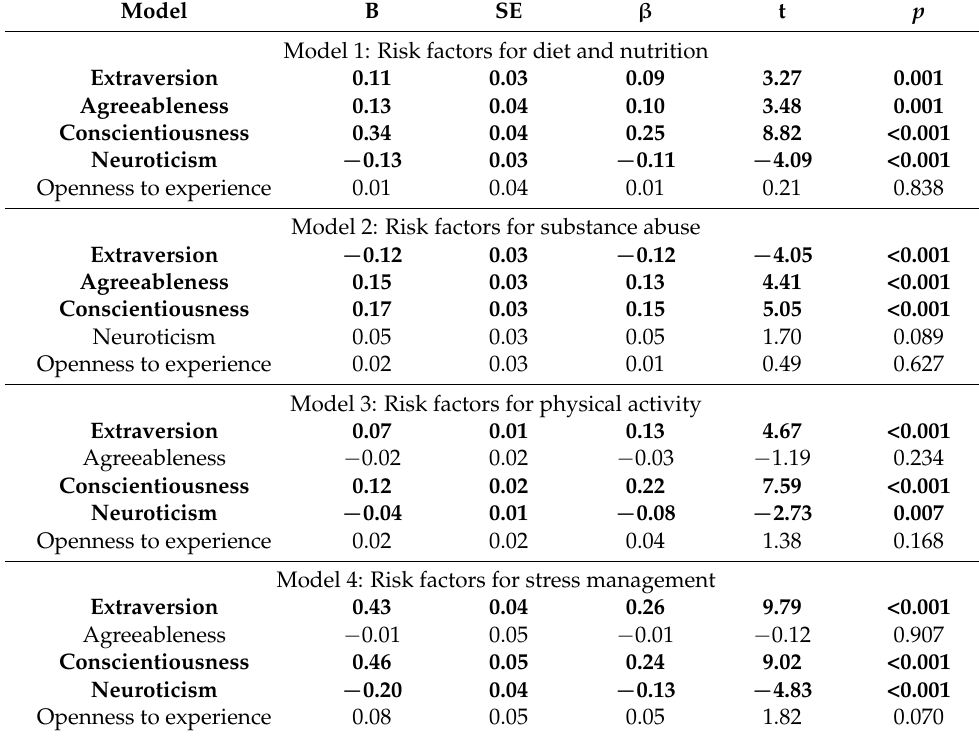
Table 2. Linear regression models that predict a healthy lifestyle during the COVID-19